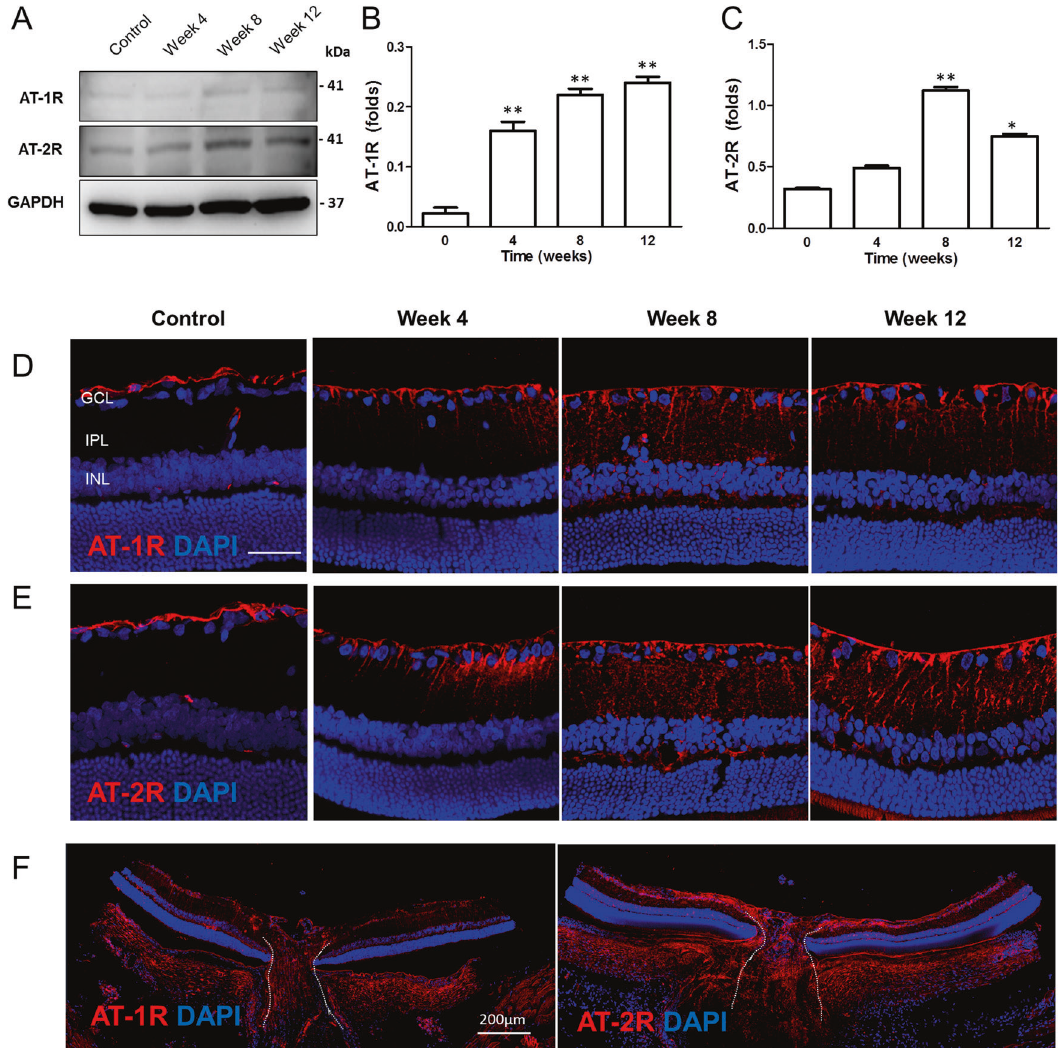
Fig. 3 Changes of AngII receptors in the retina and optic nerve head after systemic hypotension. A – C Western blot of angiotensin II receptor type 1 (AT-1R) and type 2 (AT-2R) in the retina. GAPDH was used as an endogenous control. A signi fi cant increase of AT-1R and AT-2R was observed with the exception of AT-2R at week 4. For western blot analysis, n = 6 for control and n = 6 for systemic hypotension at each time period; total n = 48. Bar represents mean ± SD. Student ’ s t -test was used for statistical evaluation. * P < 0.05 and ** P < 0.01 compared to the control. D , E Immunohistochemical staining of AT-1R and AT-2R in the retina and F optic nerve head. Increased expression of AT-1R and AT-2R was revealed throughout ganglion cell layer and inner plexiform layer of the retina, and the optic nerve head. Scale bars: 50 μ